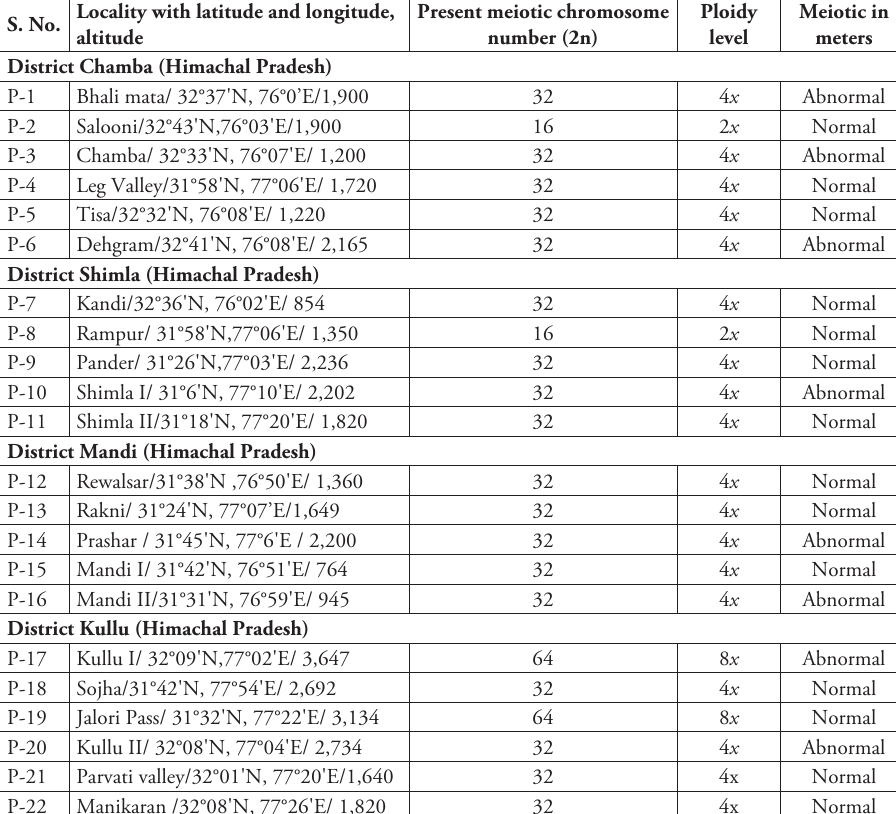
Table 1. Information about, locality, latitude and longitude, altitude, meiotic chromosome number, ploidy level and meiotic course of Valeriana jatamansi